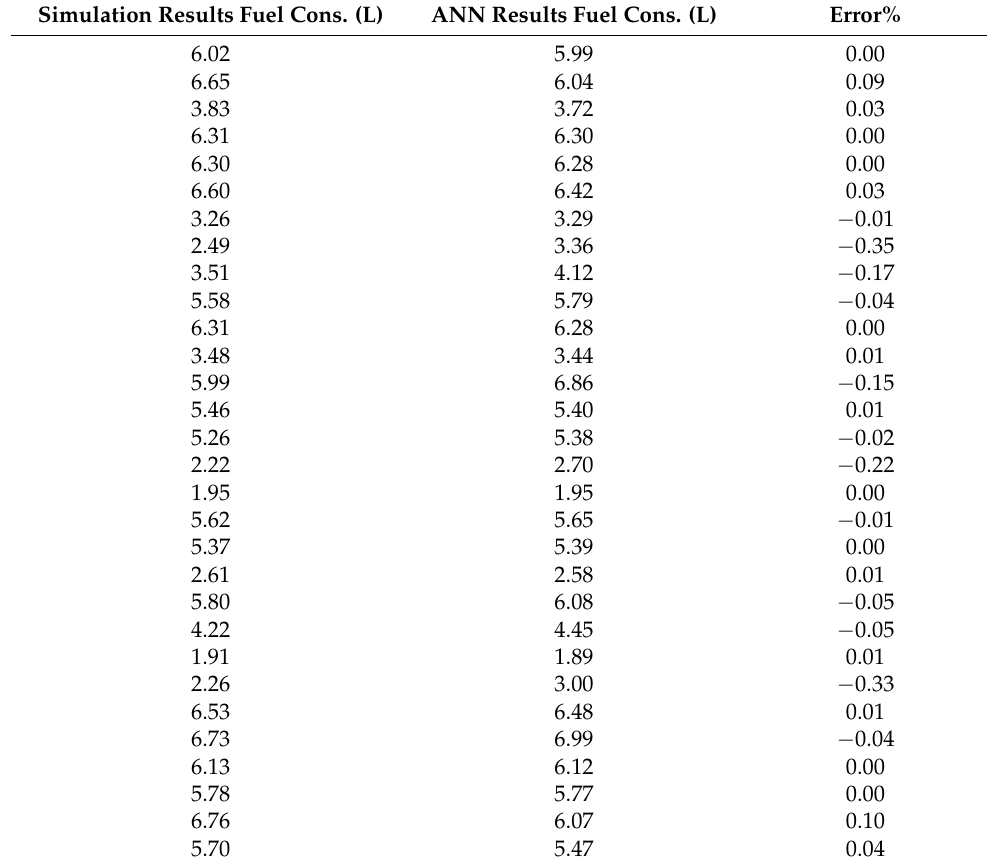
Table 3. Vehicle simulation test and ANN predicted results comparison. Simulation Results Fuel Cons.